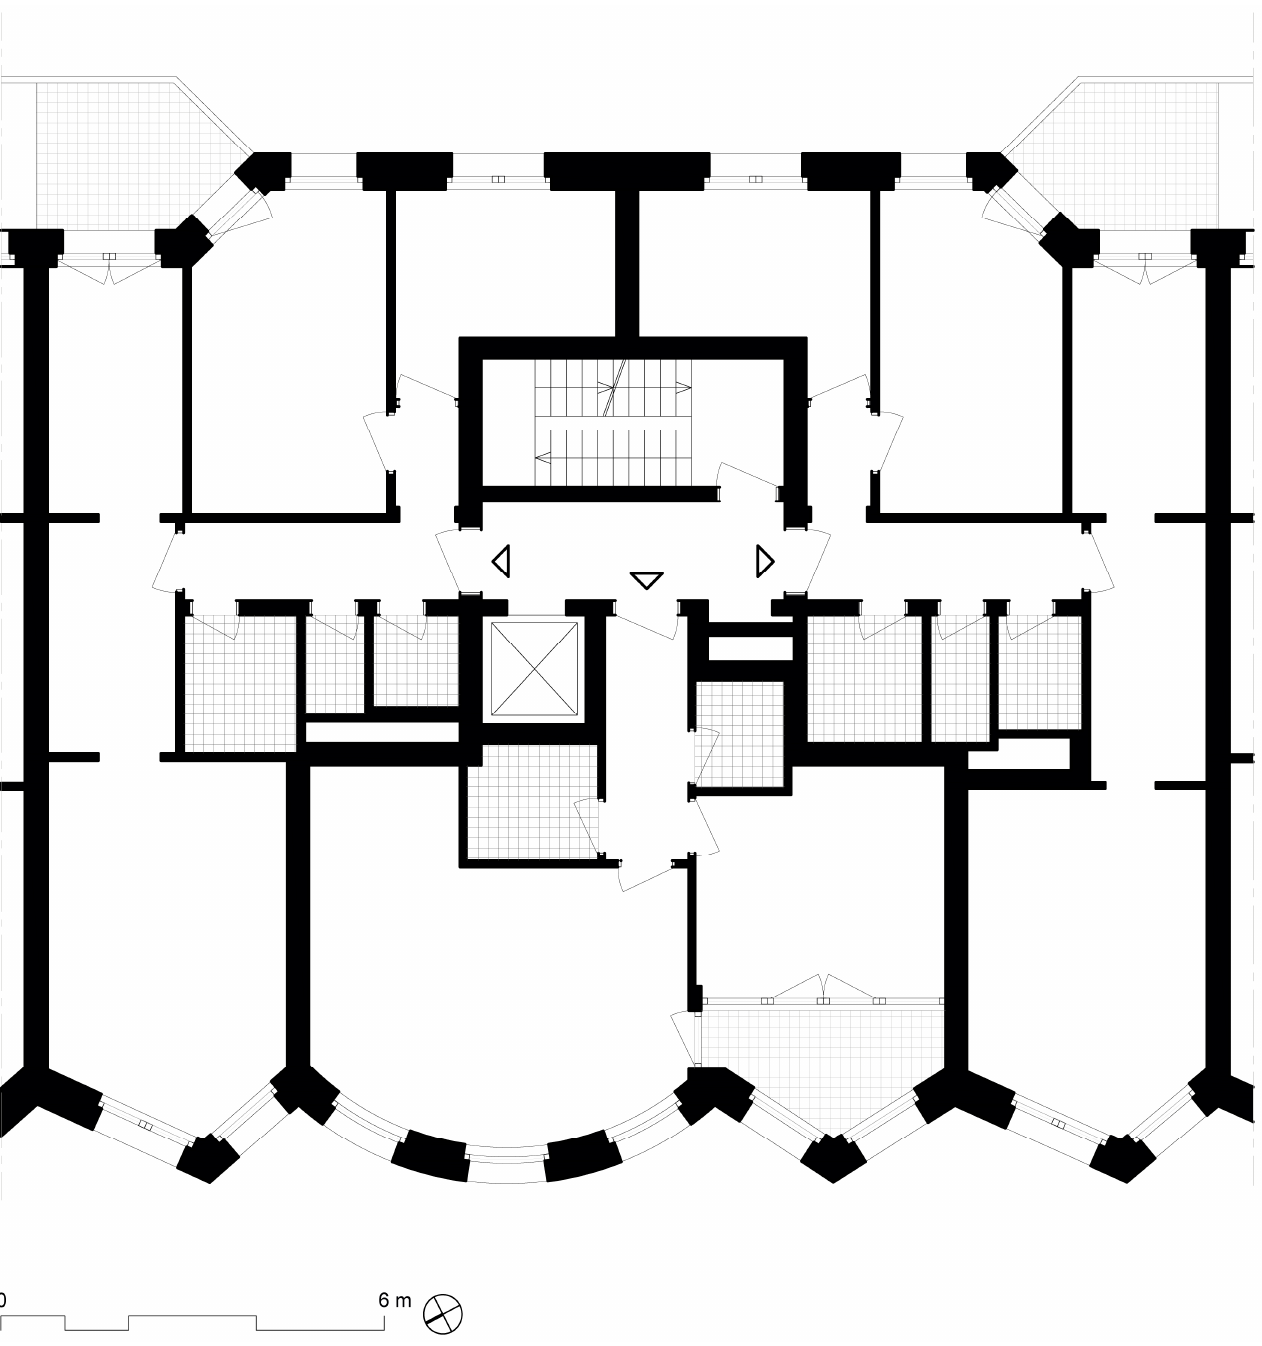
Figure 10. Dwelling plan of the project “Tour and Taxis” by Sergison Bates architects (re-drawing by the authors).